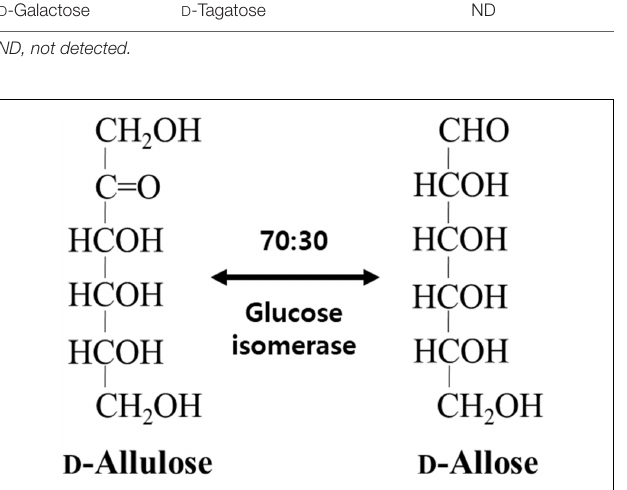
FIGURE 1 | Schematic diagram for the isomerization of D -allulose and D -allose catalyzed by commercial glucose